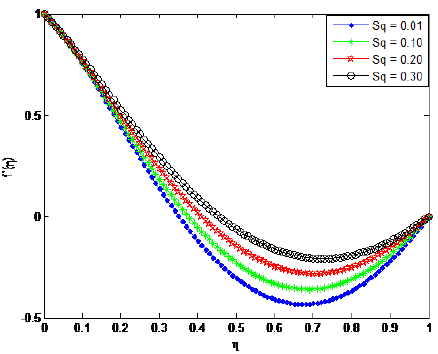
Figure 12. Influence of squeezing term on dimensionless velocity profile